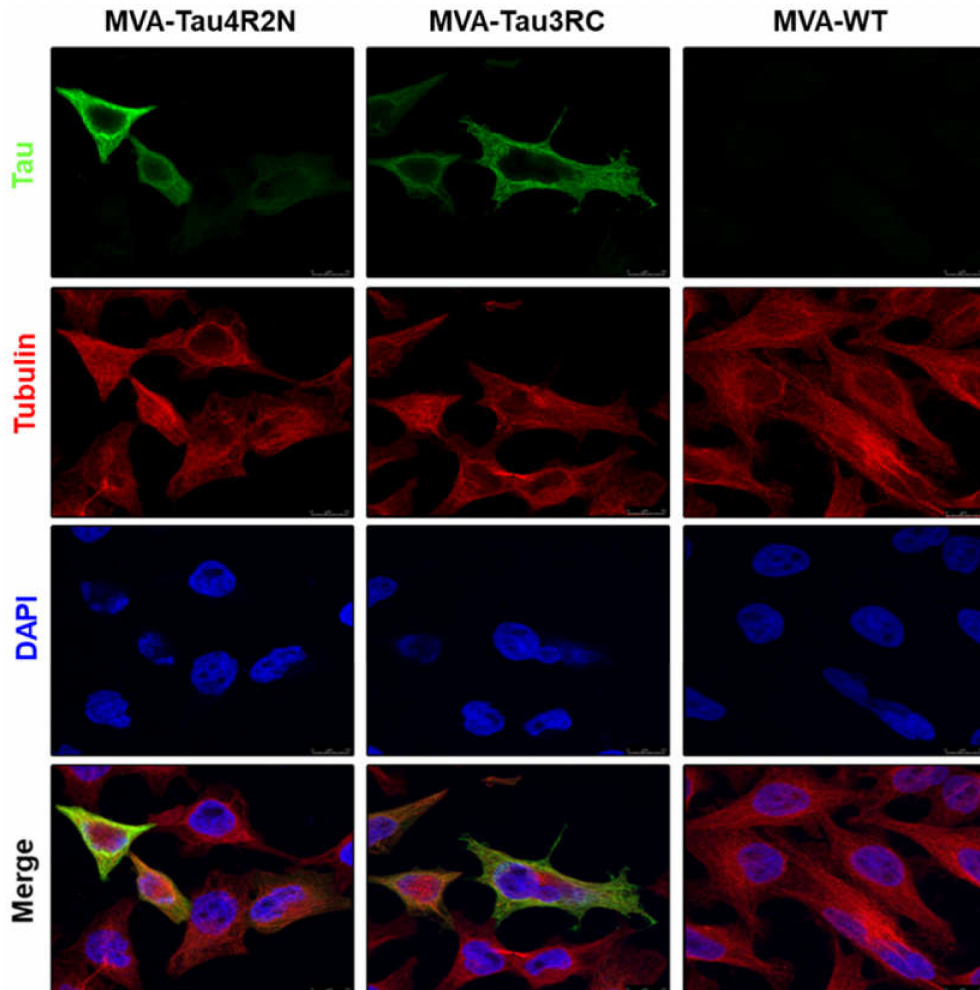
Figure 3. Immunofluorescence analysis of human tau proteins expressed by MVA-Tau4R2N and MVA-Tau3RC. HeLa cells were infected at 0.5 PFU / cell with MVA-Tau4R2N, MVA-Tau3RC, or MVA-WT for 24 h. Then, cells were fixed and permeabilized, followed by labeling with a mouse monoclonal anti-tau antibody (7.51), or a rabbit anti-tubulin antibody. Anti-tau was detected with a mouse secondary antibody conjugated with the fluorochrome Alexa Fluor 488 (green), and anti-tubulin was detected with a rabbit secondary antibody conjugated with Alexa Fluor 594 (red). Cell nuclei were stained using DAPI (blue). Scale bar: 10 µ